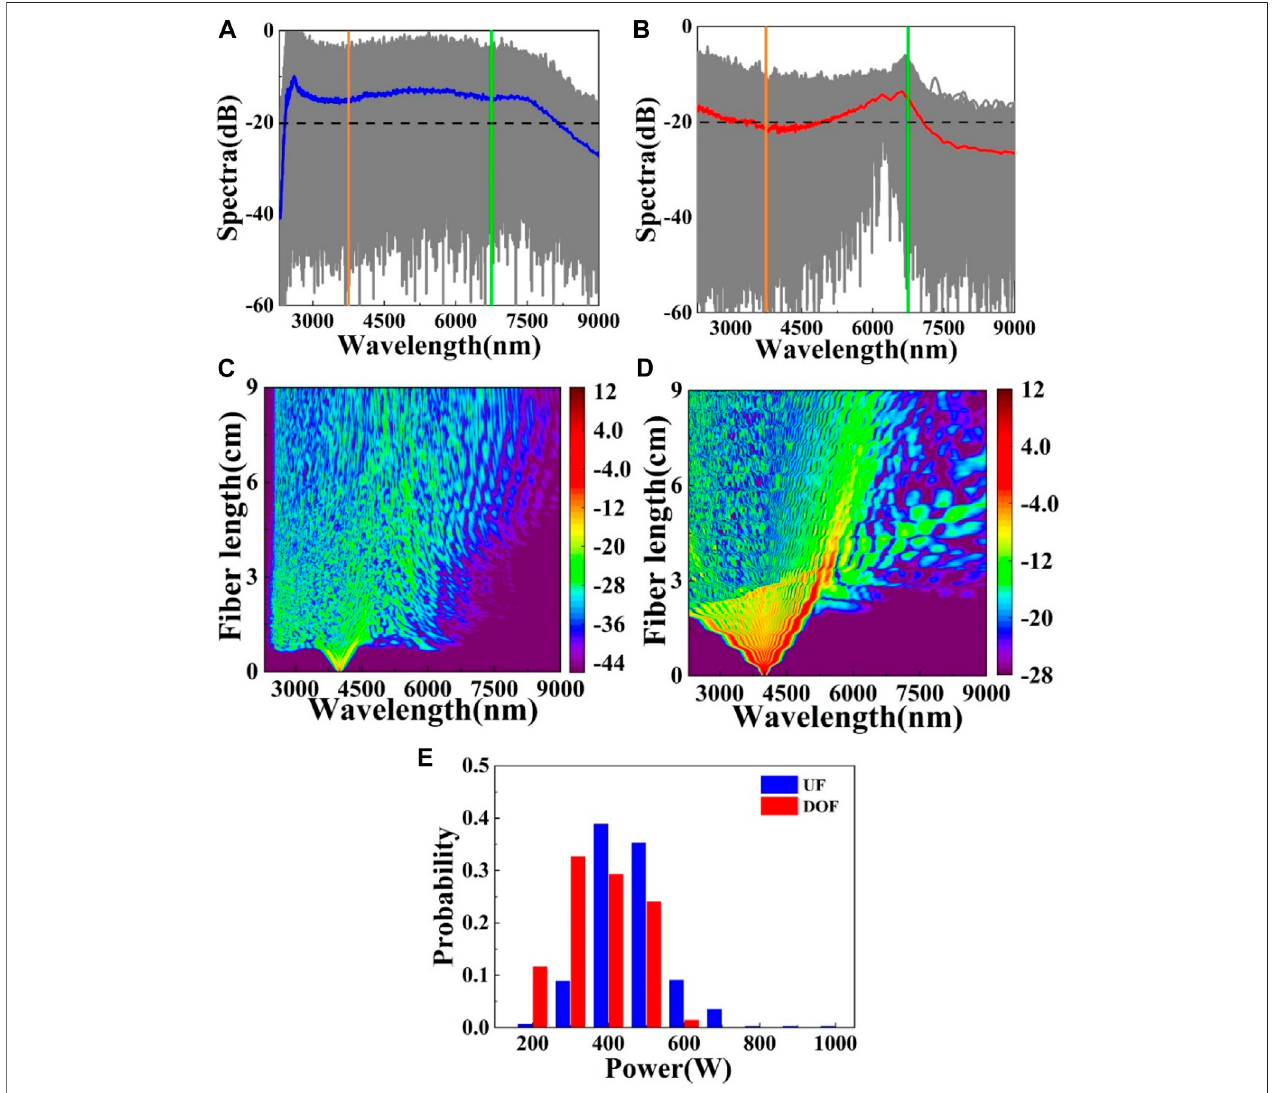
FIGURE 3 | Output mean spectra in (A) UF and (B) DOF, (C) and (D) corresponding detailed spectral evolutions dynamics in UF and DOF along the fi ber lengths, and (E) the histograms of the peak power beyond 7000 nm [green lines in (A) and (B) ]. The yellow lines in (A) and (B) is the pump wavelength 4000 nm ( P 0 (cid:2) 1.224 kW, β 21 (cid:2) 300 ps 2 /km, Λ (cid:2) 0.5 cm, φ (cid:2)